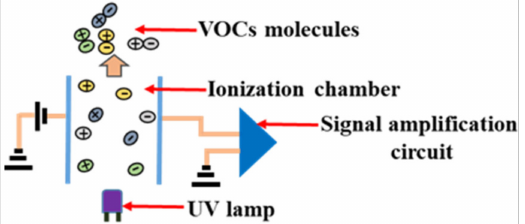
Figure 2. Working principle diagram of the PID of